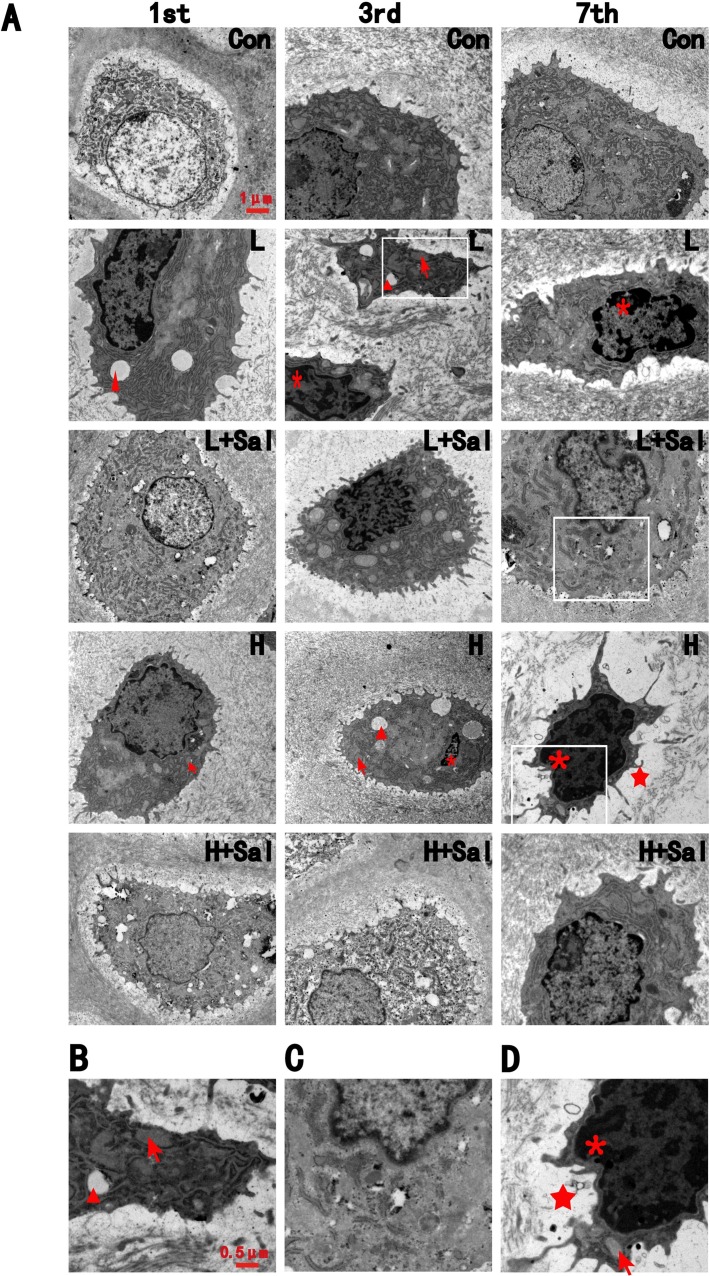
TEM revealed the ultrastructure change of chondrocytes.(A) The ultrastructure change of chondrocytes under various compressive stresses after injecting Salubrinal at days 1, 3 and 7.ER dilation is indicated by an arrow, condensed chromatin is indicated by an asterisk, vesicles are indicated by triangles, and decreasing collagen deposition indicated by a pentagram. Scale bars, 1 μm. (B) Higher magnification in the day-3 light compressive stress subgroup. ER dilation is indicated by an arrow, vesicles are indicated by triangle. Scale bars, 0.5 μm. (C) Higher magnification in the day-7 light compressive stress subgroup after injecting Salubrinal. (D) Higher magnification in the day-7 heavy compressive stress subgroup. ER dilation is indicated by an arrow, condensed chromatin is indicated by an asterisk,and decreasing collagen deposition indicated by a pentagram.